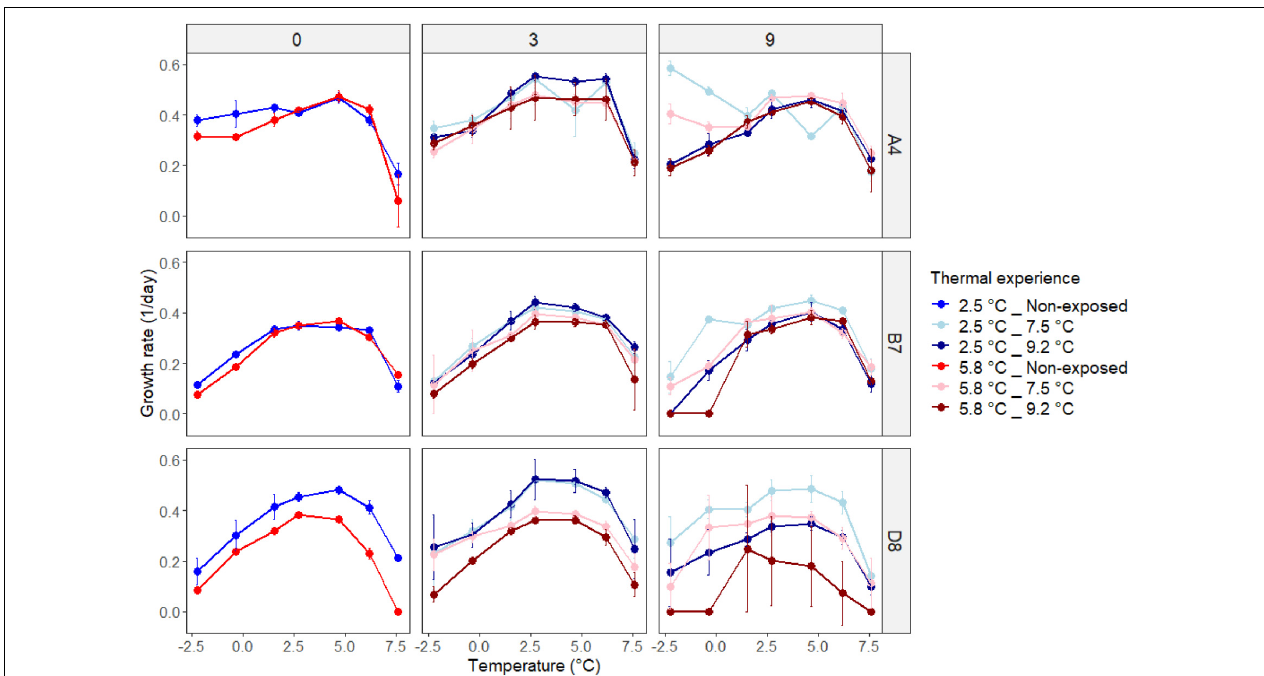
FIGURE 3 | Maximum growth rates of non-exposed (d0) and heatwave-exposed (d3 and d9) experimental populations at seven temperatures for each genotype. Thermal experience combines acclimation temperature (2.5 or 5.8 ◦ C) and heatwave temperature (7.5 or 9.2 ◦ C). Data shown are average values across three replicates ± one standard